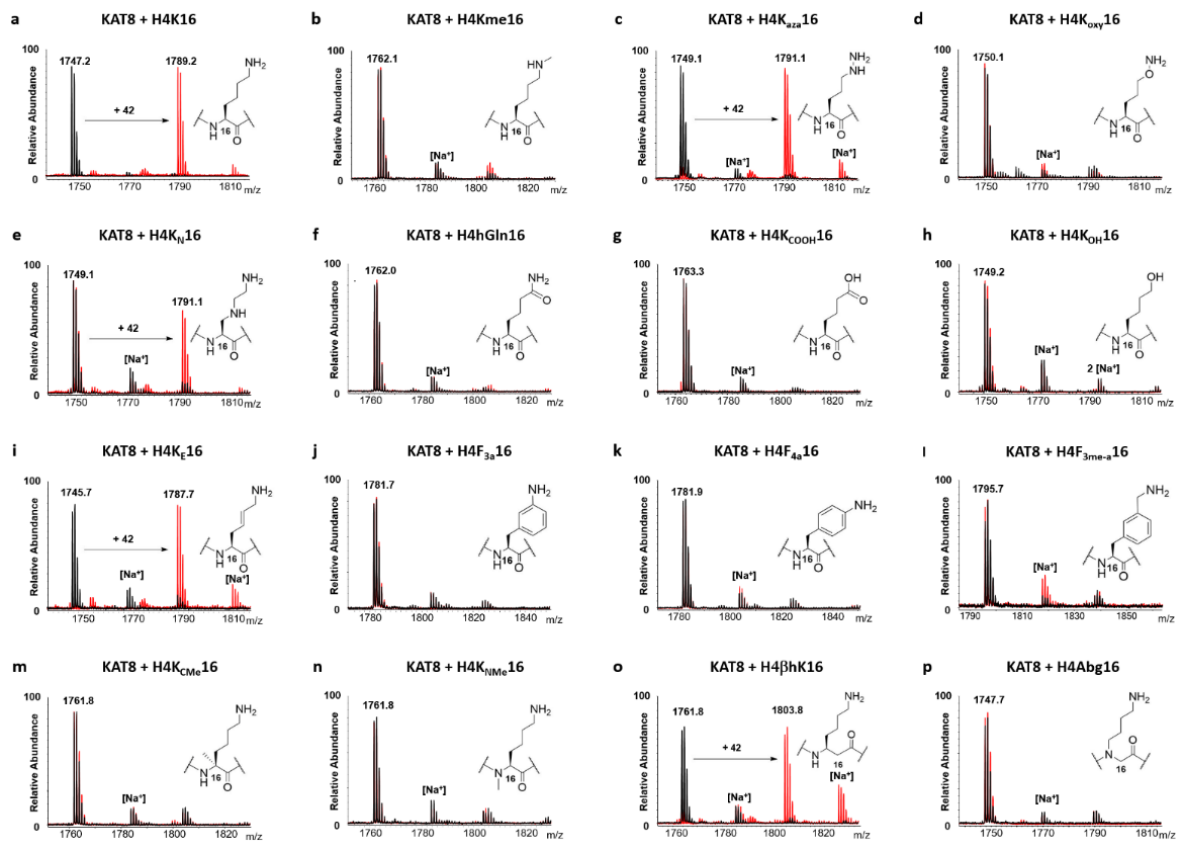
Figure 3. MALDI-TOF MS data showing the KAT8 (2 µ M)-catalysed acetylation of H4K*16 histone peptides (100 µ M) in the presence of AcCoA co-substrate (300 µ M) ( a – p ); Overlaid MS spectra of KAT8-catalysed reactions (red) and no enzyme control reactions (black) that were quenched after being incubated for 3 h at 37 °C.